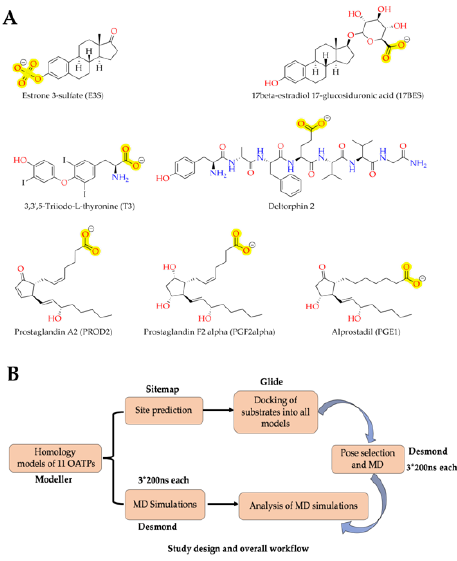
Figure 1. ( A ) 2D structure representation of the compounds OATP ligands employed in this study, negatively charged anions are highlighted in yellow. ( B ) Overall study design and workflow fol- lowed.